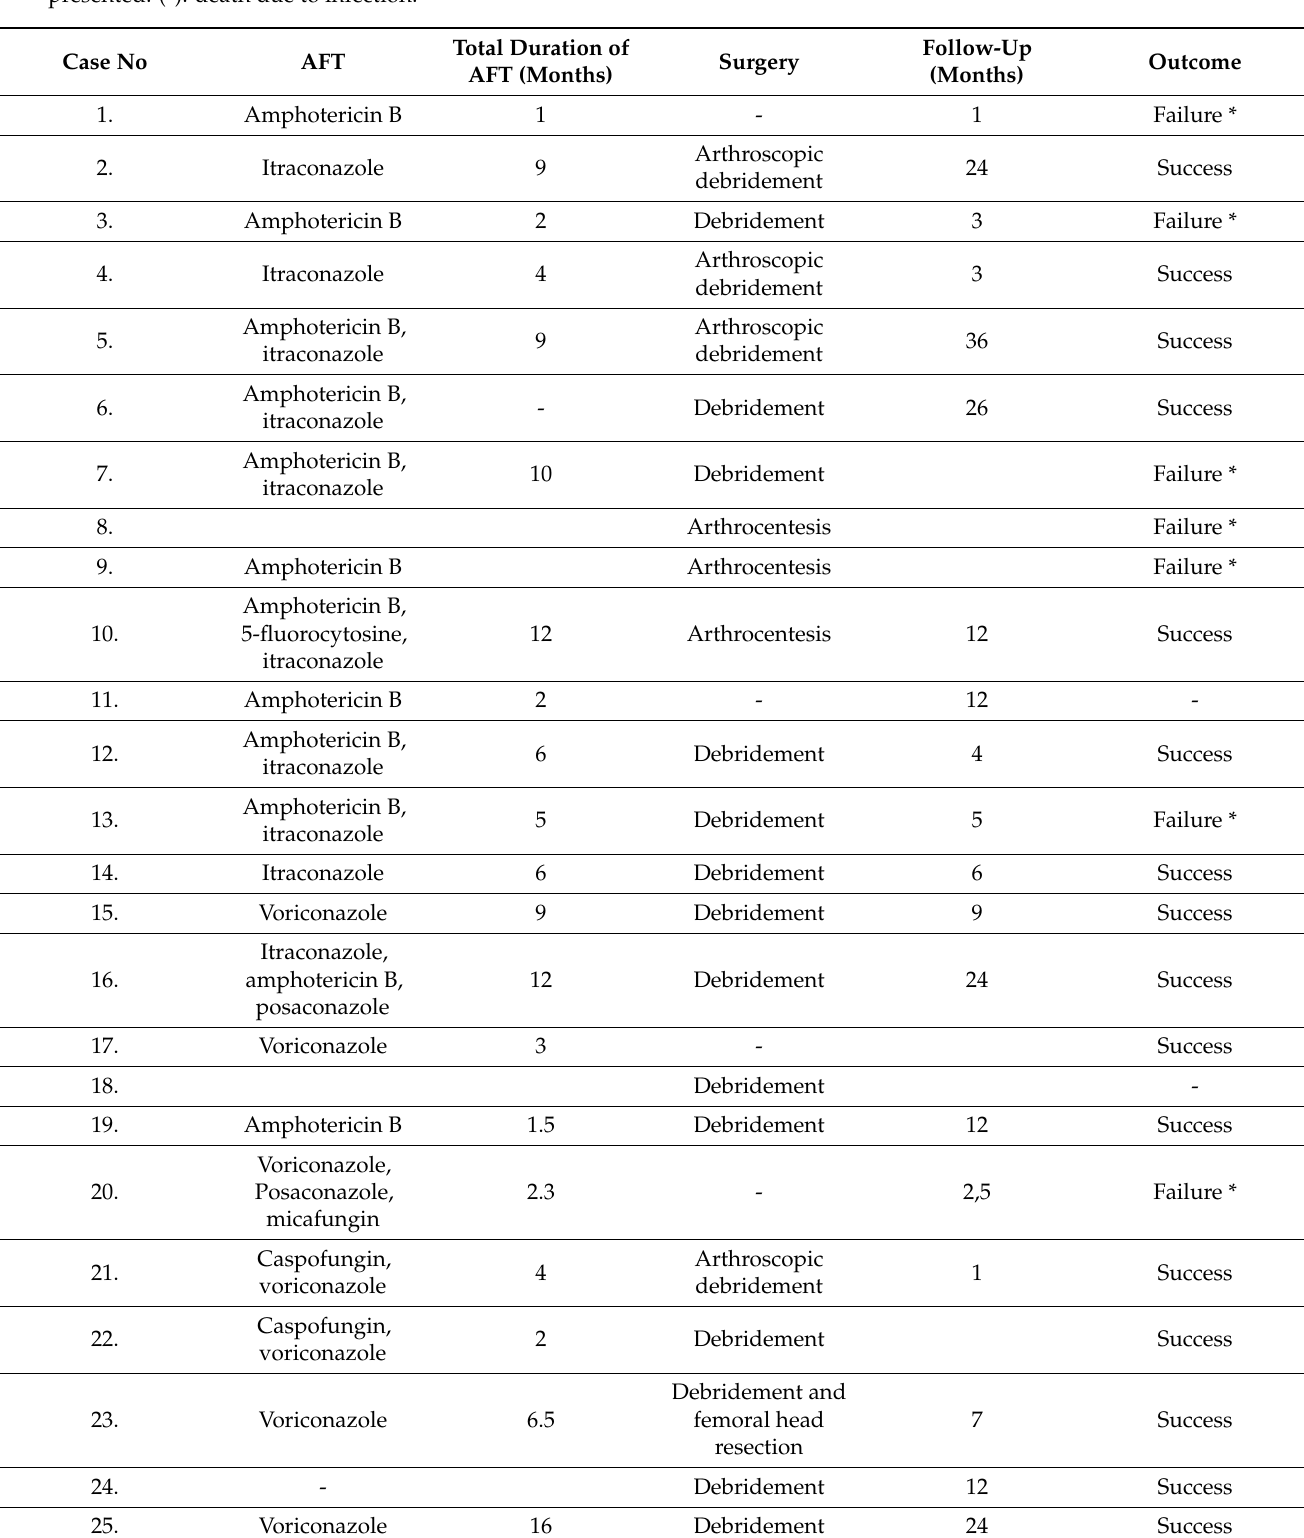
Table 2. Antifungal treatment (AFT), duration of AFT, Surgical intervention, follow-up and infection’s outcome are presented. (*): death due to